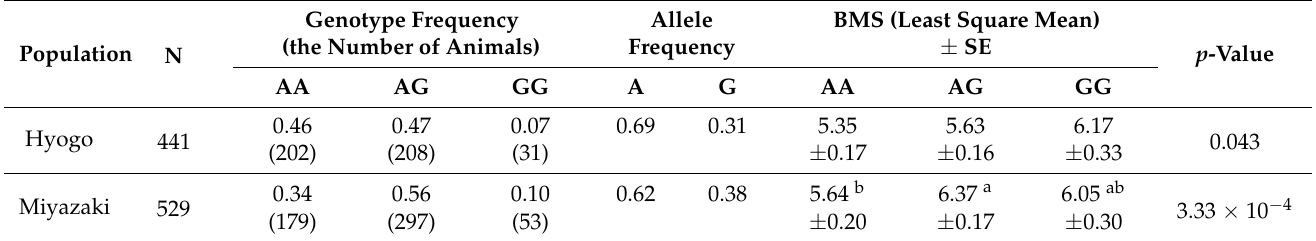
Table 2. Effect of SNP37_ ICAM1 on BMS in two Japanese Black